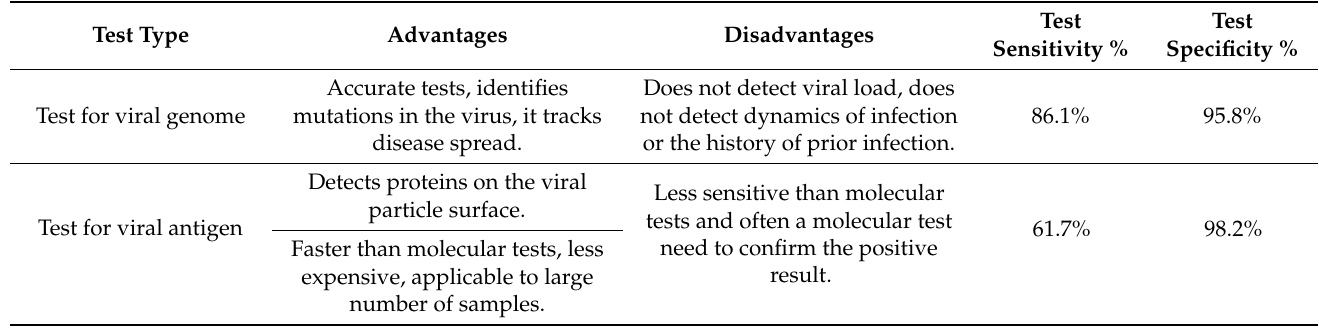
Table 1. Main characteristics of molecular and antigen tests in